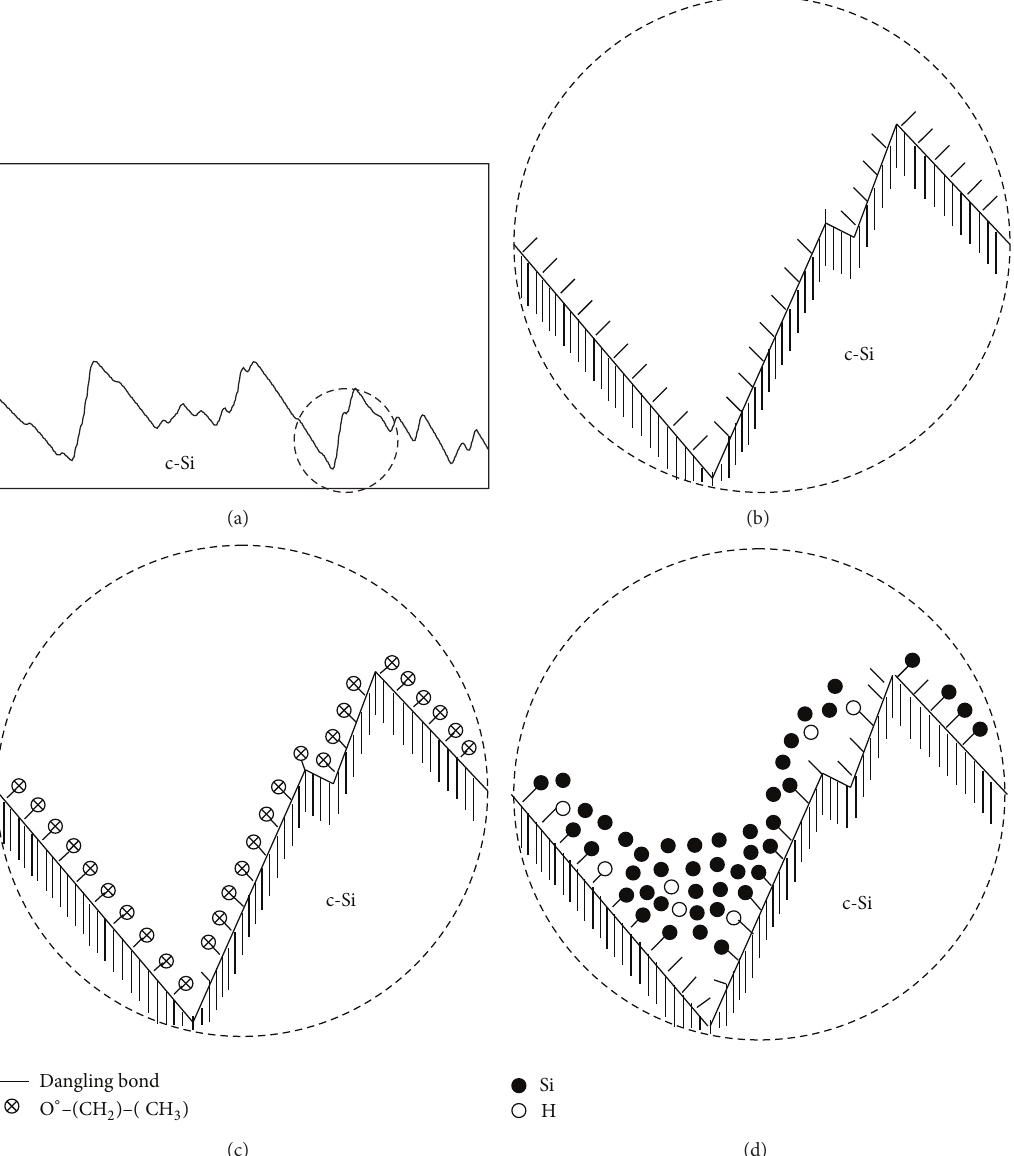
Figure 3: (a) Surface profile of the 90 min etched wafer and schematic diagrams of the wafer surface dangling bonds (b) without passivation, (c) passivated by iodine-ethanol solution and (d)